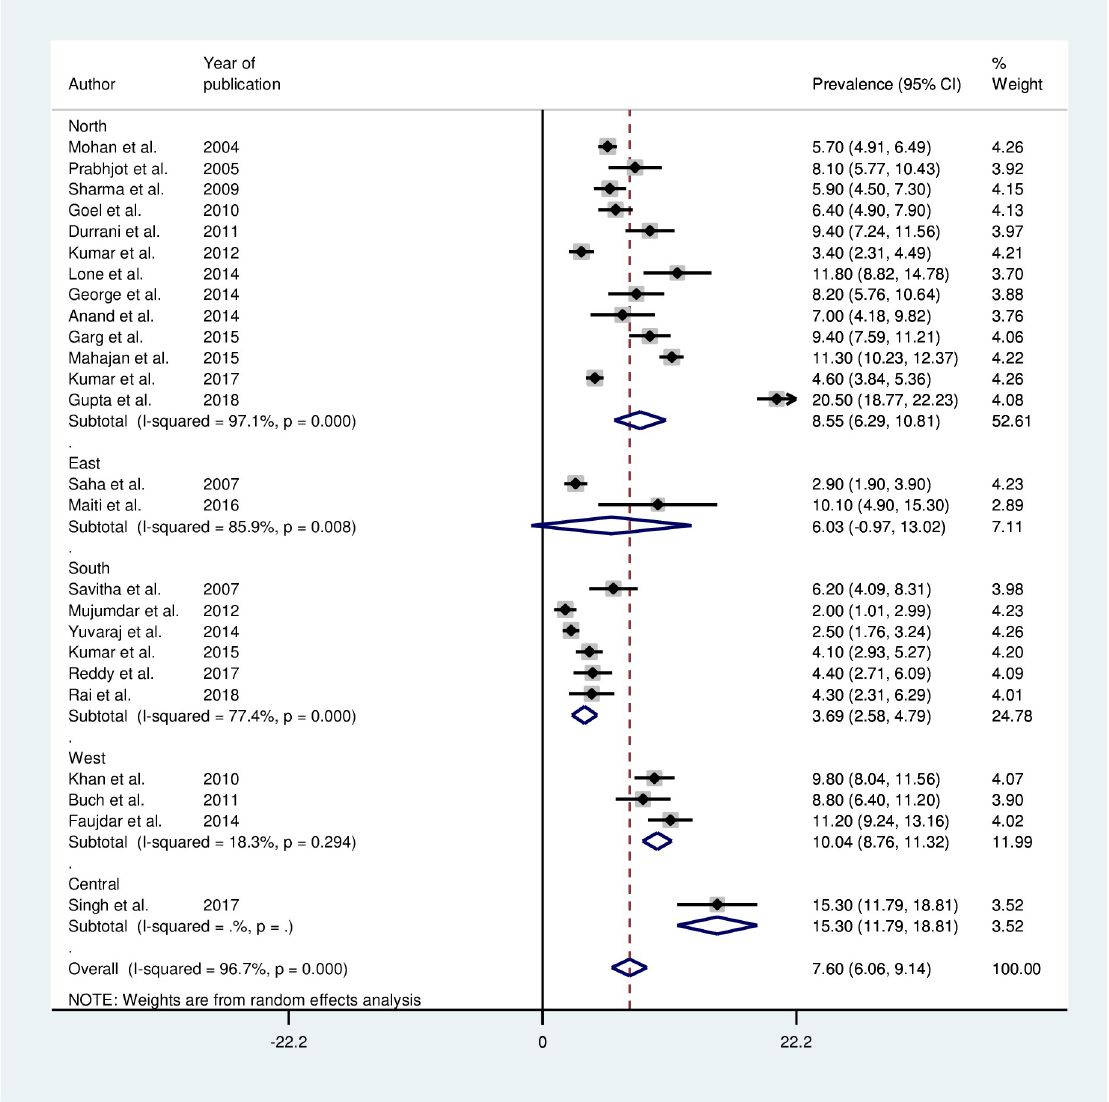
Fig 3. Forest plot of region wise prevalence of hypertension among adolescents in